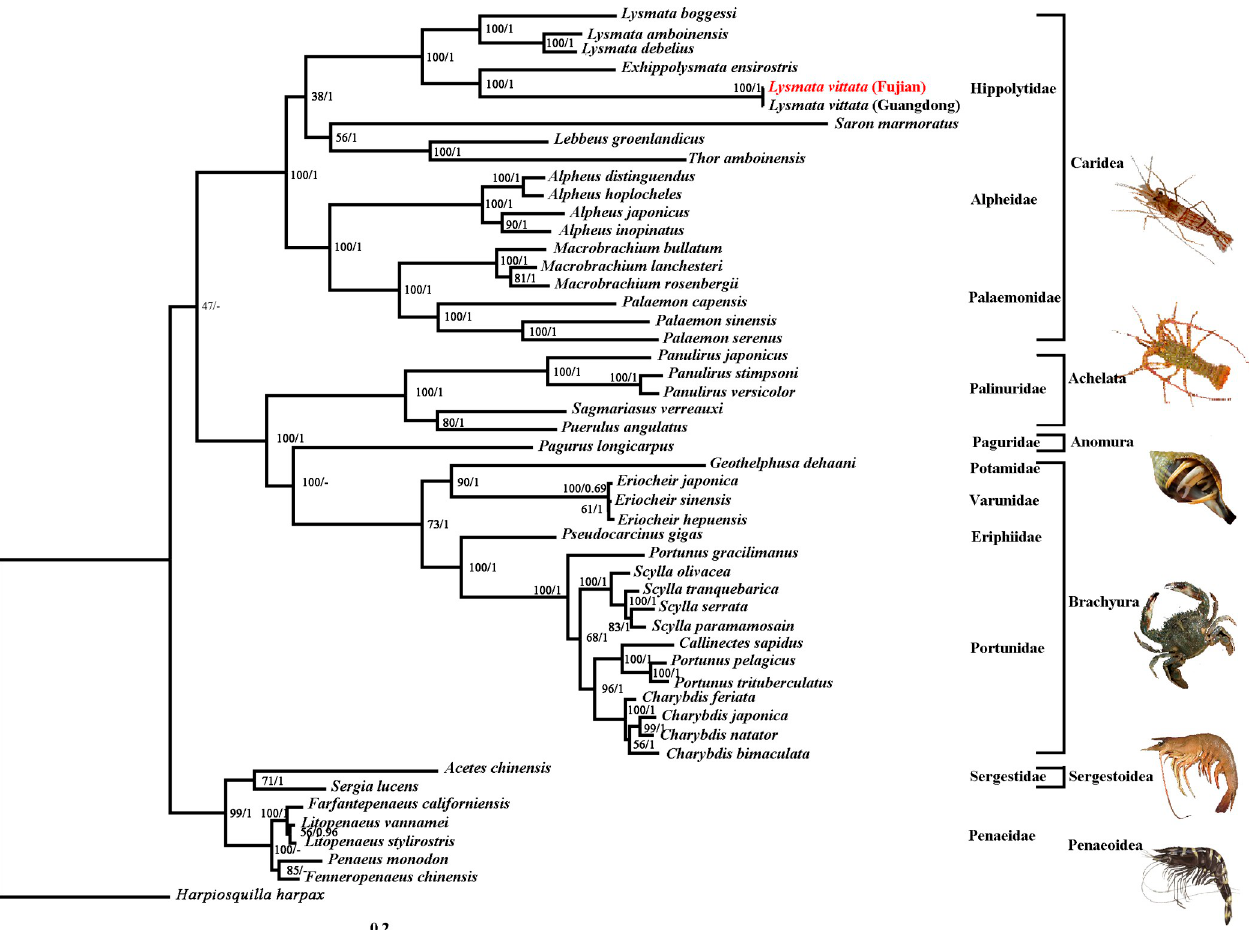
Fig 5. Phylogenetic tree inferred from amino acid sequences of 13 PCGs of the mitogenome using ML and BI methods (BP/PP).